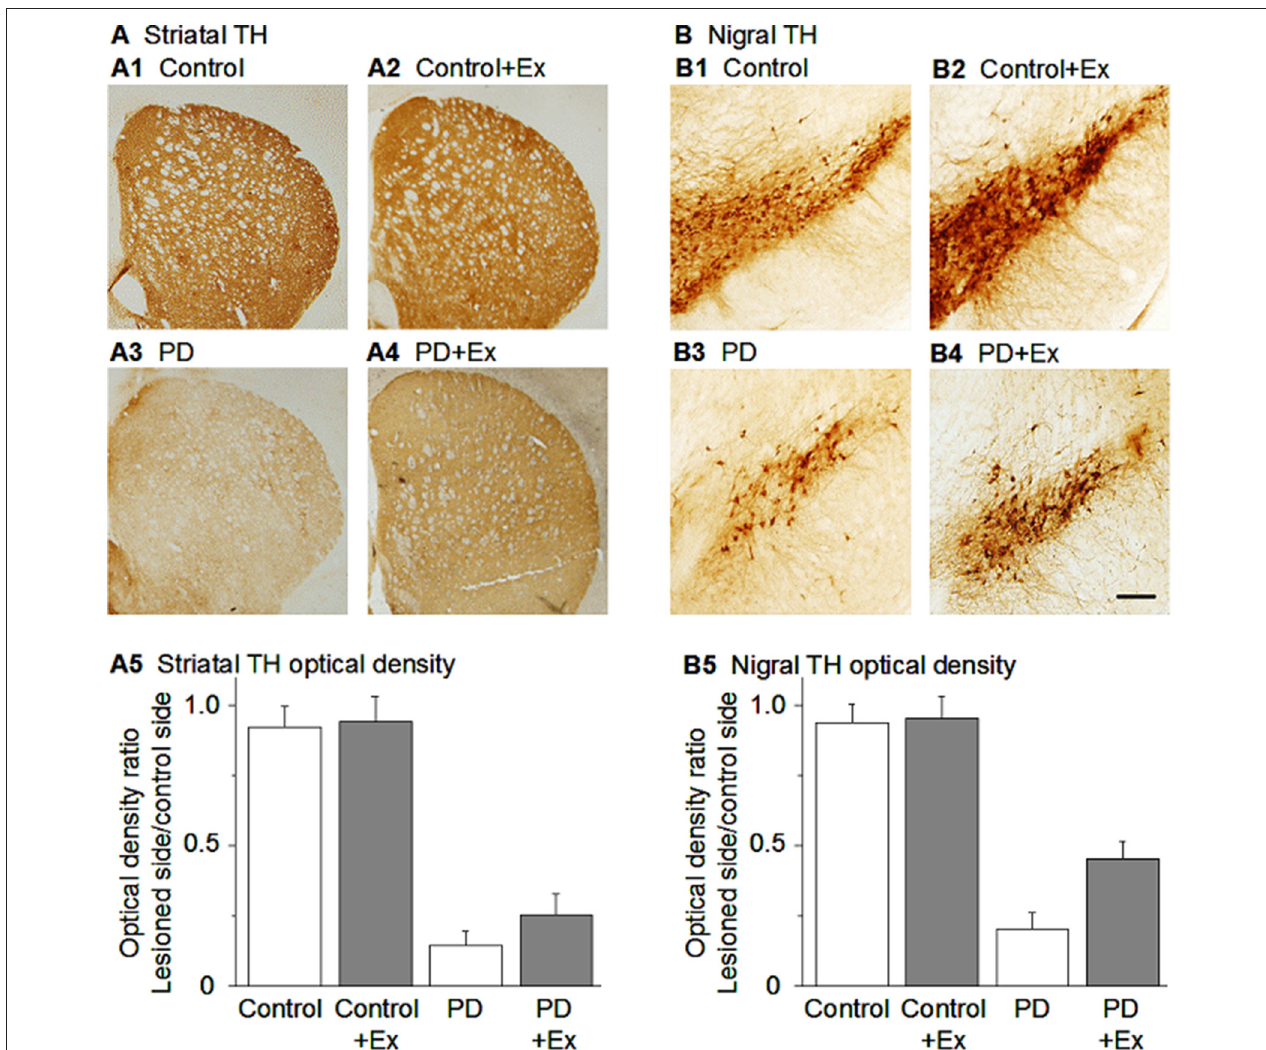
FIGURE 3 | Exercise-induced neuroprotection of DA neurons in the SNc and DA axon terminals in the striatum. (A) TH immunostain showing DA axonal innervation under the four conditions. (B) TH immunostain showing DA neurons in the substantia nigra under the four conditions. Scale bar in (B4) : 0.1mm for (A) and 0.05mm for (B) . Modified from Shi et al. (2017) with